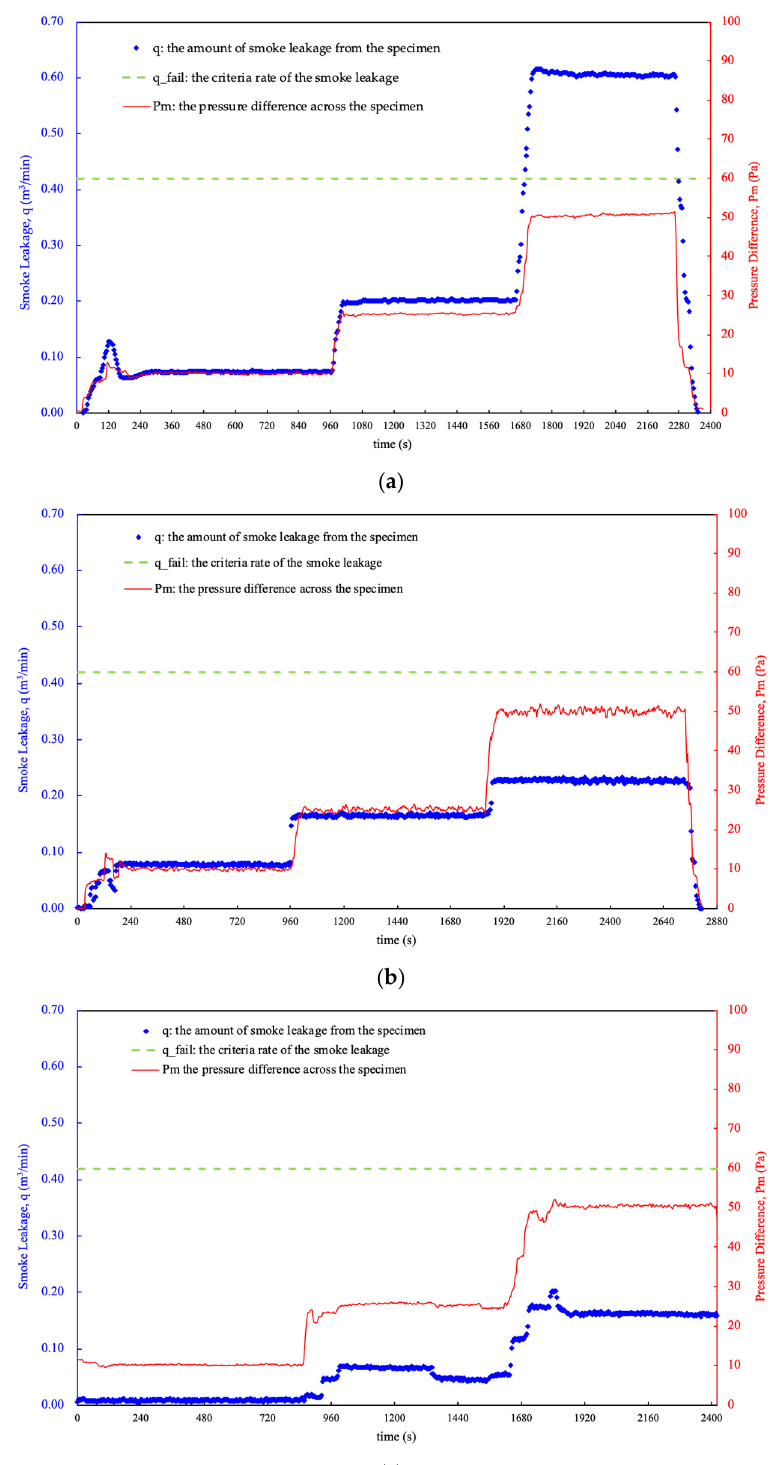
Figure 12. Smoke control performances of the fire retardant curtain: ( a ) without a water film system at normal temperature, ( b ) with a water film system at normal temperature, and ( c ) with the water film system at 200 °C.